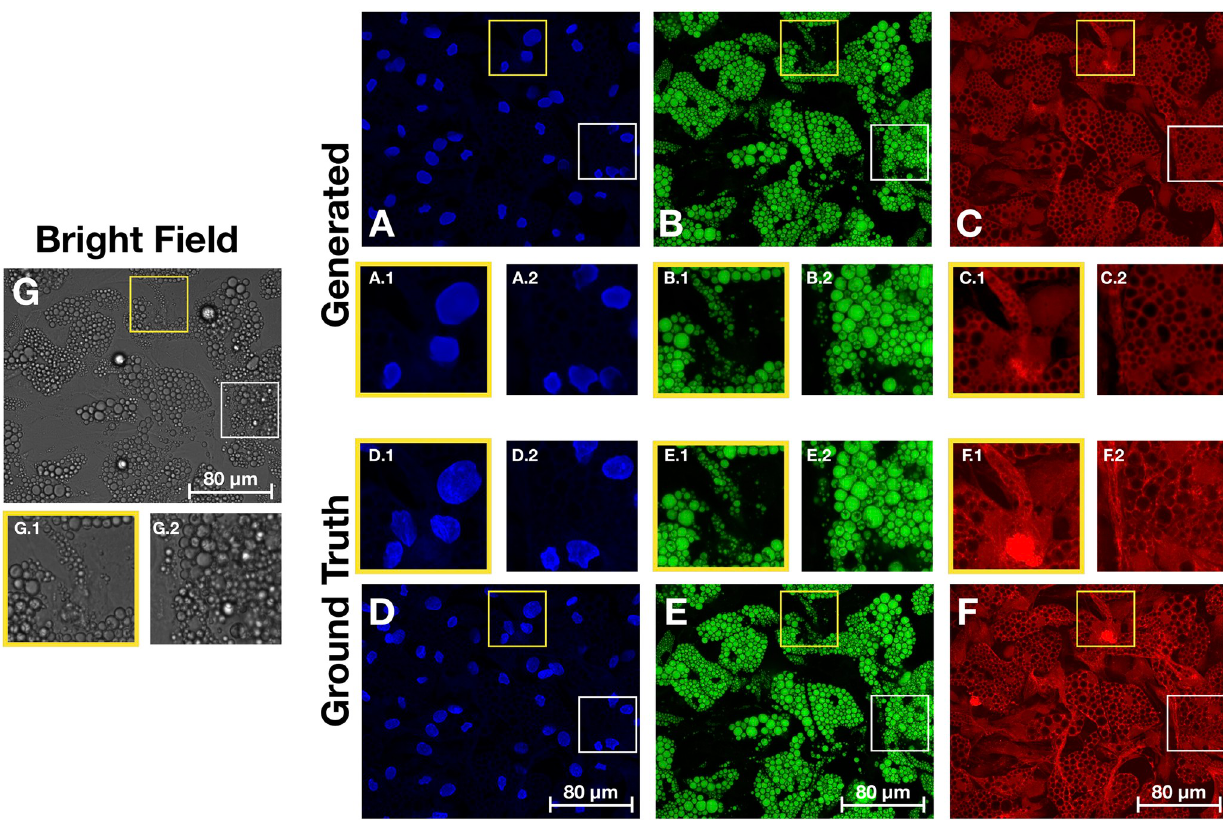
Fig 9. Comparison of images generated from the bright-field z-stack and the ground truth fluorescence images. A-C . Generated images for the nuclei, lipid droplets and cytoplasm, with zoomed in regions showing some well reconstructed areas alongside some more problematic locations. D-F Ground truth images with corresponding zoomed in regions. G Maximum projection of the bright-field z-stack with corresponding zoomed in regions. Images are displayed with the same dynamic range per channel for visualization purpose.